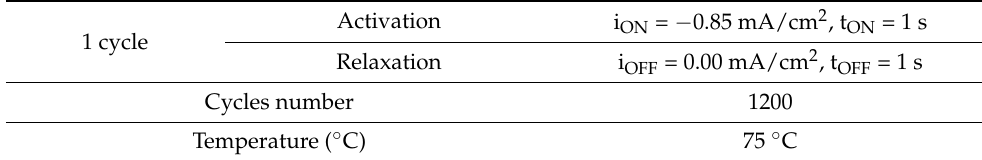
Table 2. Main electrochemical parameters involved in the deposition process.